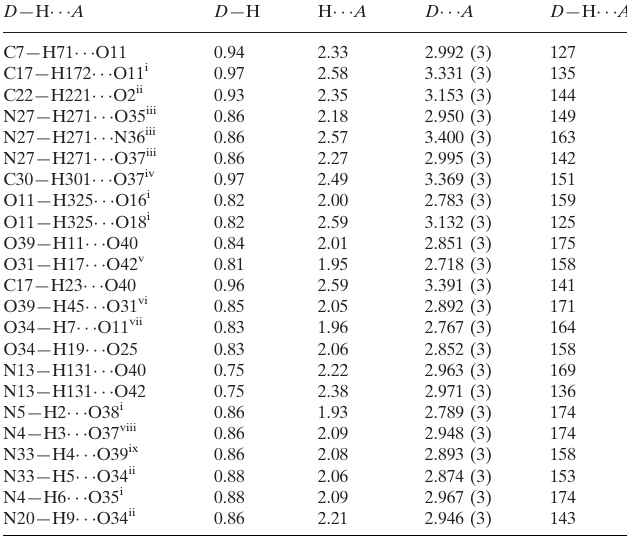
Hydrogen-bond geometry (A˚ , (cid:4)